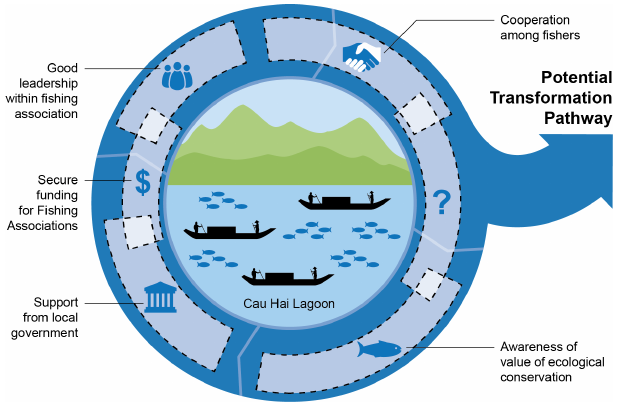
Fig. 3 . Building blocks for social-ecological transformation in the Cau Hai Lagoon. Dotted blocks suggest supporting conditions for transformation; the nonlinear arrangements of blocks along the pathway is a reminder that building blocks will not be the same for all Fishing